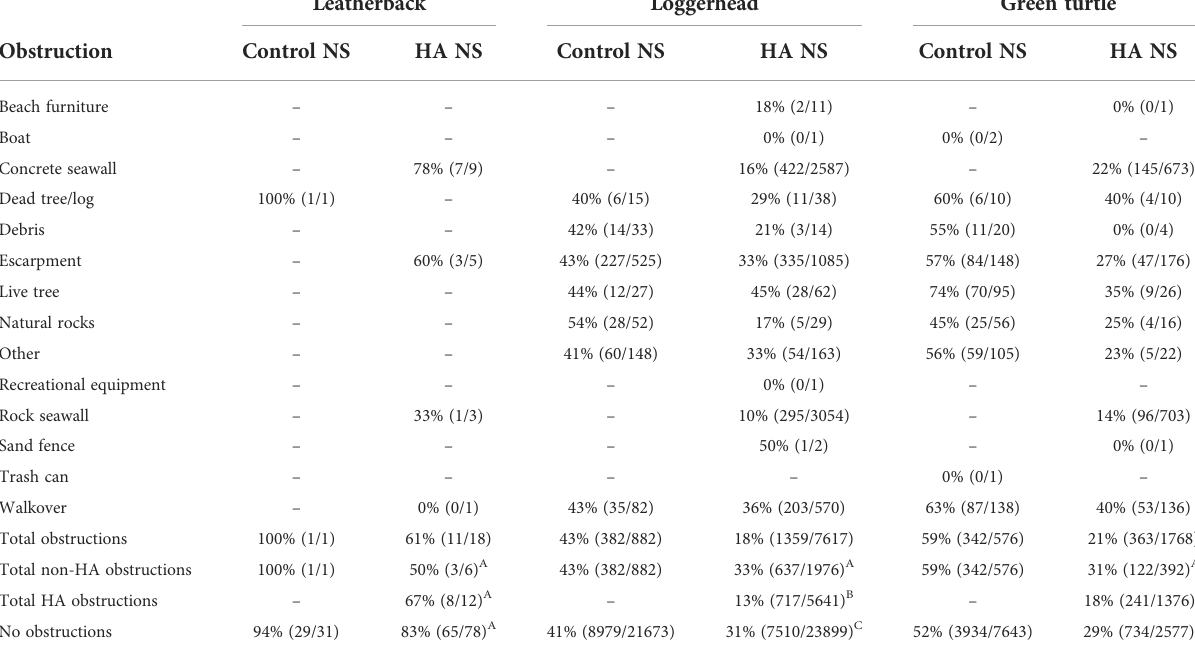
TABLE 2 Obstructions encountered by nesting leatherback ( Dermochelys coriacea ), loggerhead ( Caretta caretta ), and green ( Chelonia mydas ) sea turtles in Tequesta and Jupiter Inlet Colony Beaches, Florida, USA from 2007 – 2021 at the control site and the hard-armoring (HA)